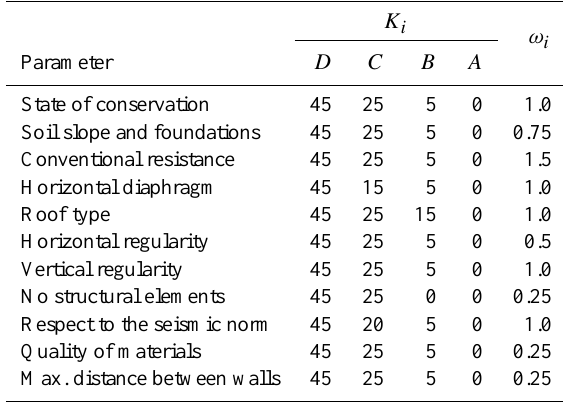
Table 1. Parameters and their relative weight in Benedetti-Petrini’s